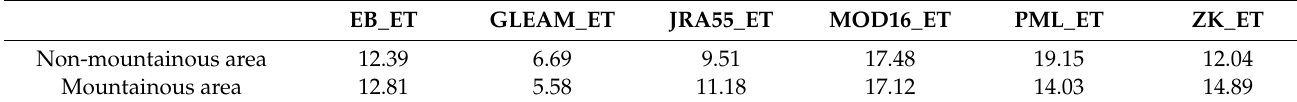
Figure 10. Relative uncertainties (unit: %) of the six ET products at the monthly-scale. Table 4. Relative uncertainties (%) of the six products in mountainous and non-mountainous areas.